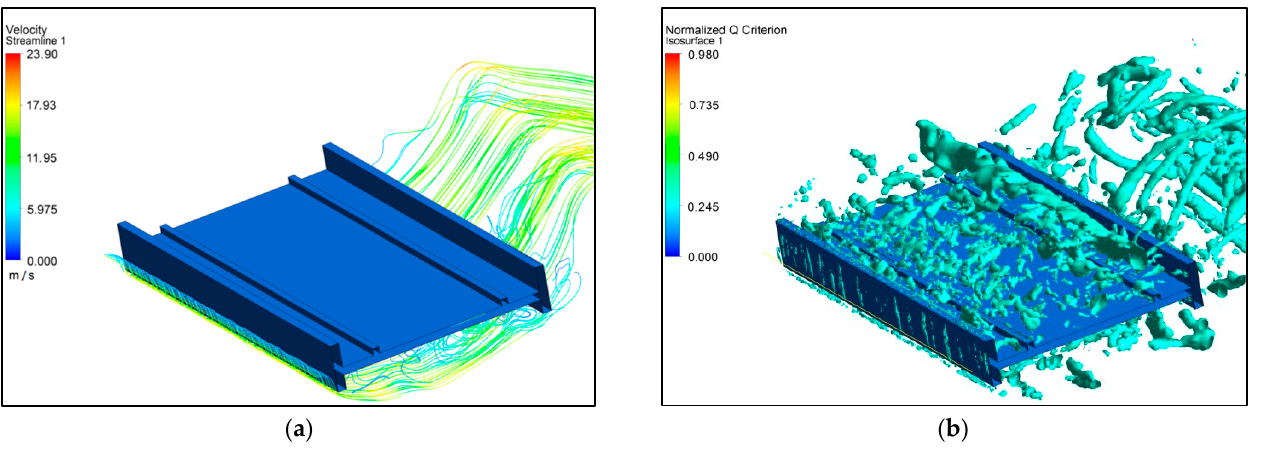
Figure 7. The results of numerical calculations of the flow around the model No. 1 with solid walls: ( a ) Picture of current lines in the near model; ( b ) Isosurface of the Q-criterion near model.